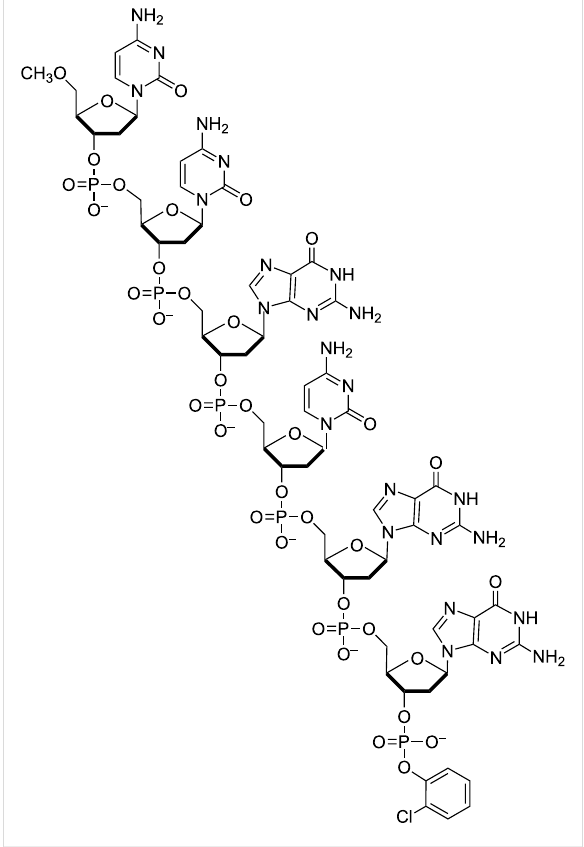
Figure 4: The first oligonucleotide capable of template directed self- replication without the need of enzymes. The depicted hexamer tem- plate T is formed from two trimer building blocks and catalyzes its own formation. Self-reproduction of this molecule was shown to result in parabolic growth of the template concentration